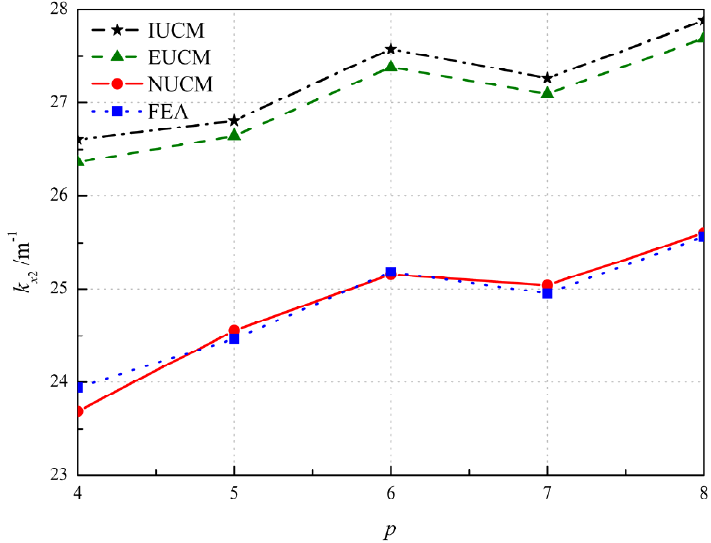
Figure 6. Variation of the principal curvature with respect to the number of plies p. Table 3. Principal curvature of anti-symmetric cylindrical shells with di ff erent number of plies from analytical model and